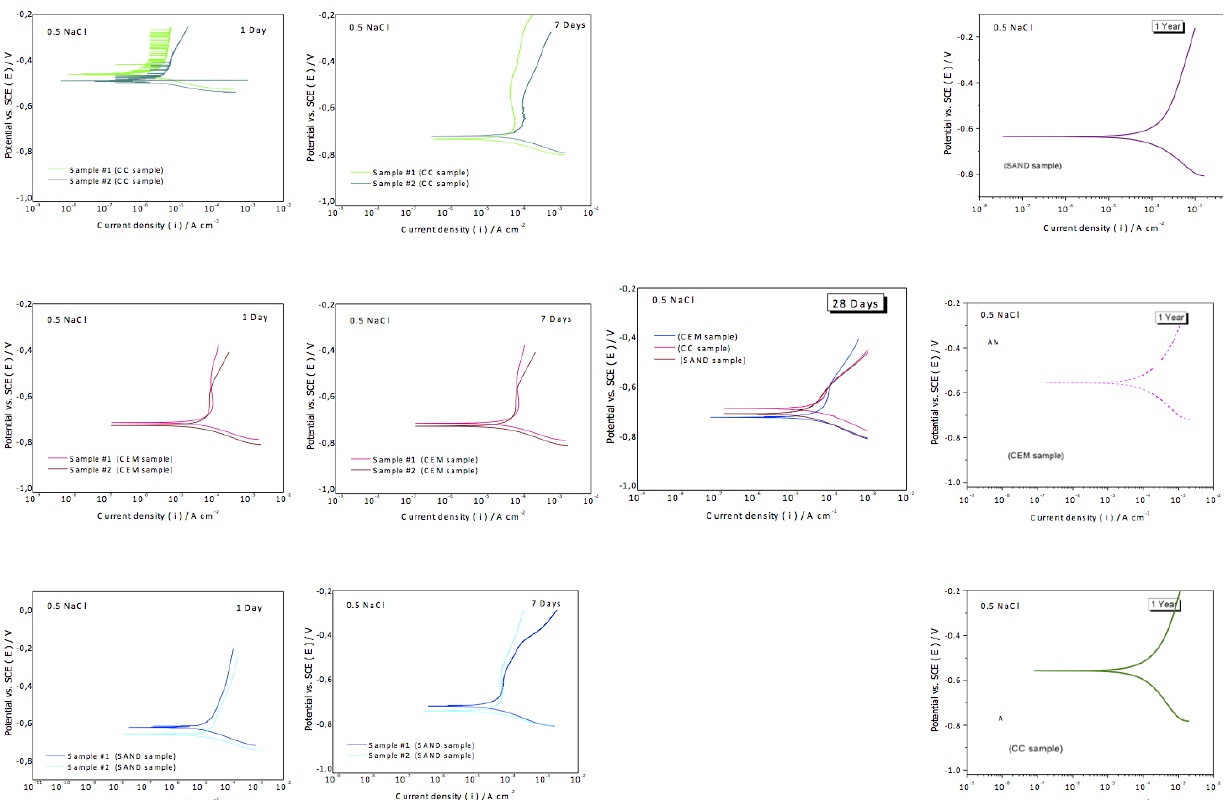
Figure 11. Experimental results of potentiodynamic polarization curves in NaCl for all examined samples in NaCl solution considering distinctive immersion periods (1 days, 7, 28 and 365 days).